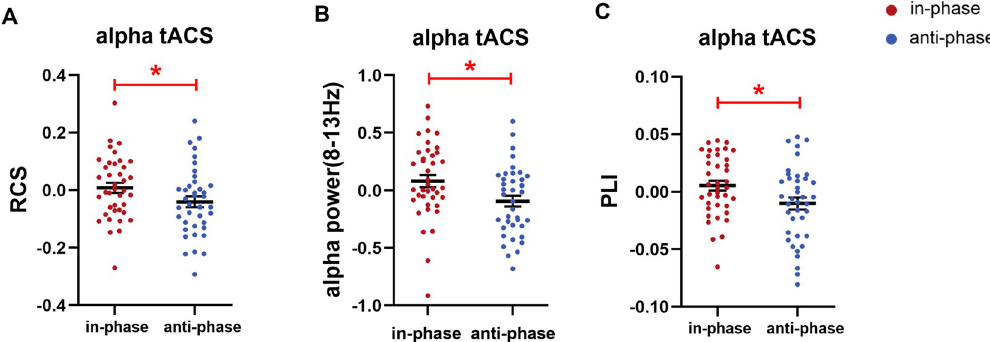
Fig 4. The behavioral and electrophysiological effects of parietal alpha tACS in Experiment 1. During Online tACS, anti- phase tACS at the IAF significantly decreased ( A ) WM performance (i.e., RCS), ( B ) parietal alpha power (8–13 Hz), and ( C ) frontoparietal alpha synchronization (indexed by PLI) as compared to in-phase tACS. Note that all instances of the RCS, alpha power, and PLI values are given relative to the Baseline data (i.e., values after subtracting the corresponding Baseline values). Error bars represent the SEM across participants. � Significant at p < 0.05 (two-tailed permuted paired t -tests). The underlying data supporting Fig 4 can be found in the Supporting information as S1 Data. IAF, individual alpha frequency; PLI, phase lag index; RCS, rate correct score; SEM, standard error of the mean; tACS, transcranial alternating current stimulation; WM, working